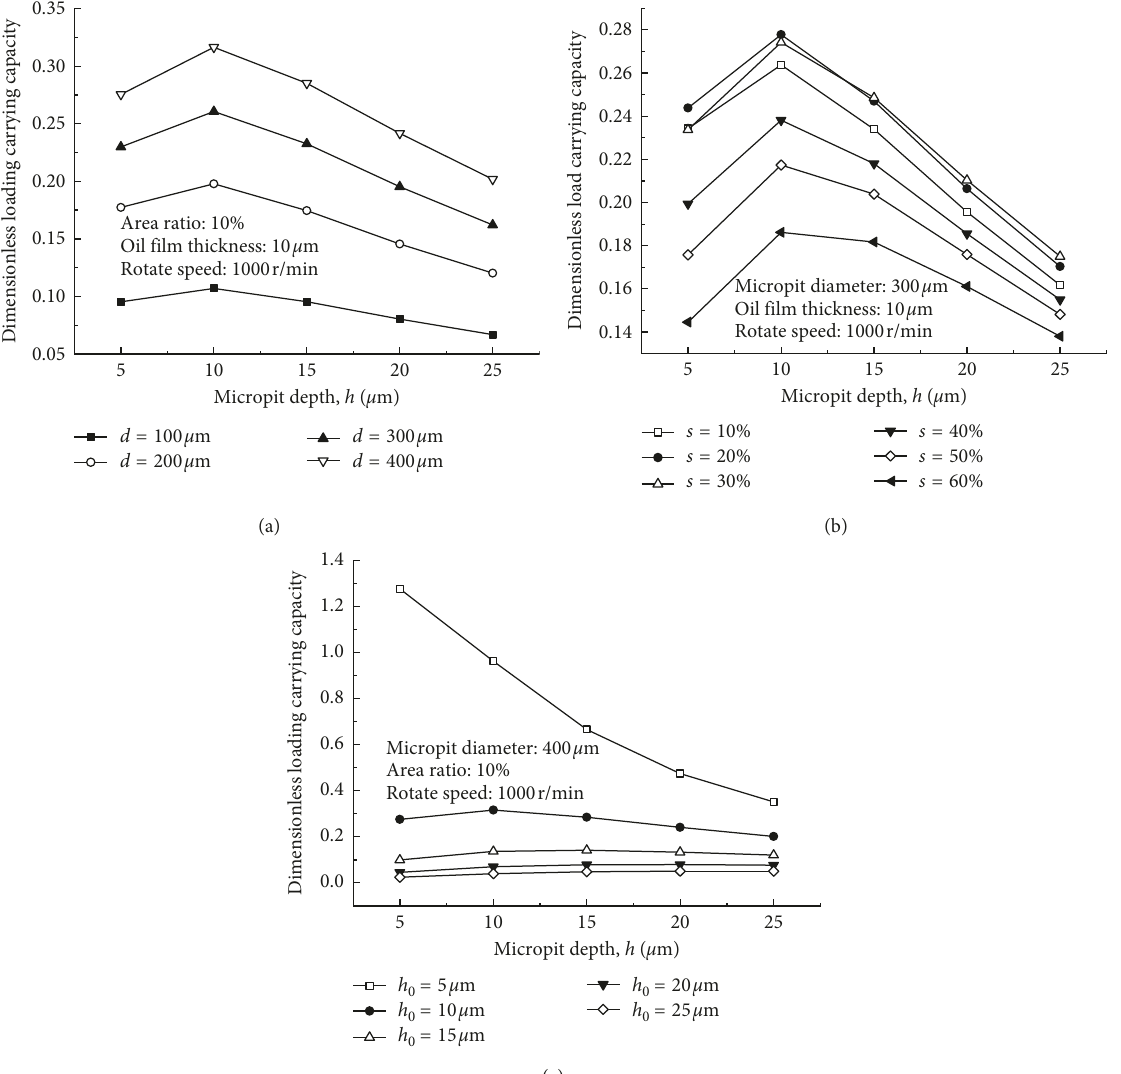
Figure 2: Relation between dimensionless pressure and micropits’ depth. (a) The different micropit diameter. (b) The different micropit depth. (c) The different oil film